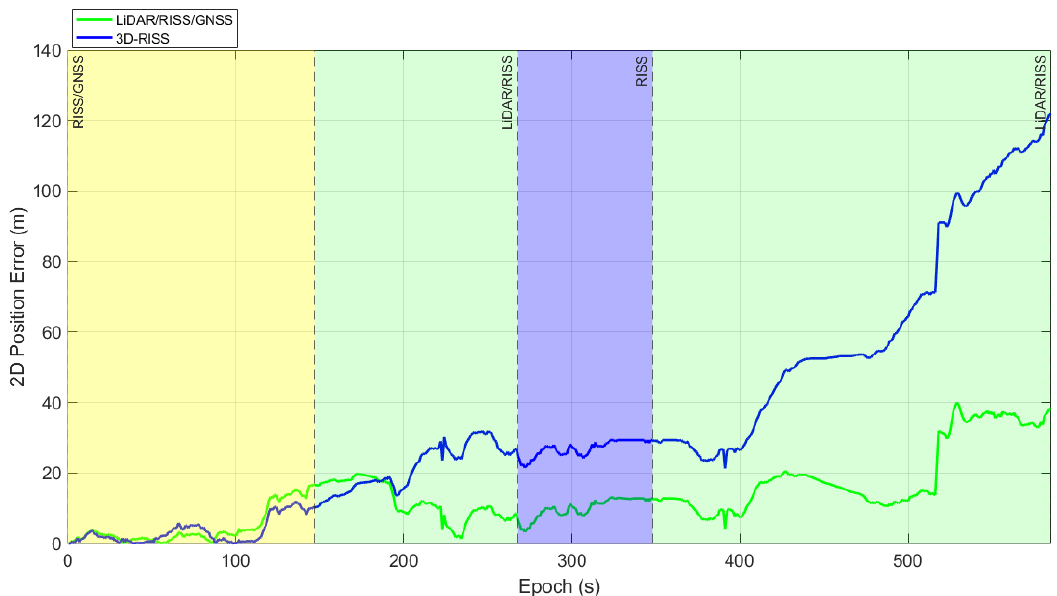
Figure 21. 2D Position Error for Second Trajectory Scenario.